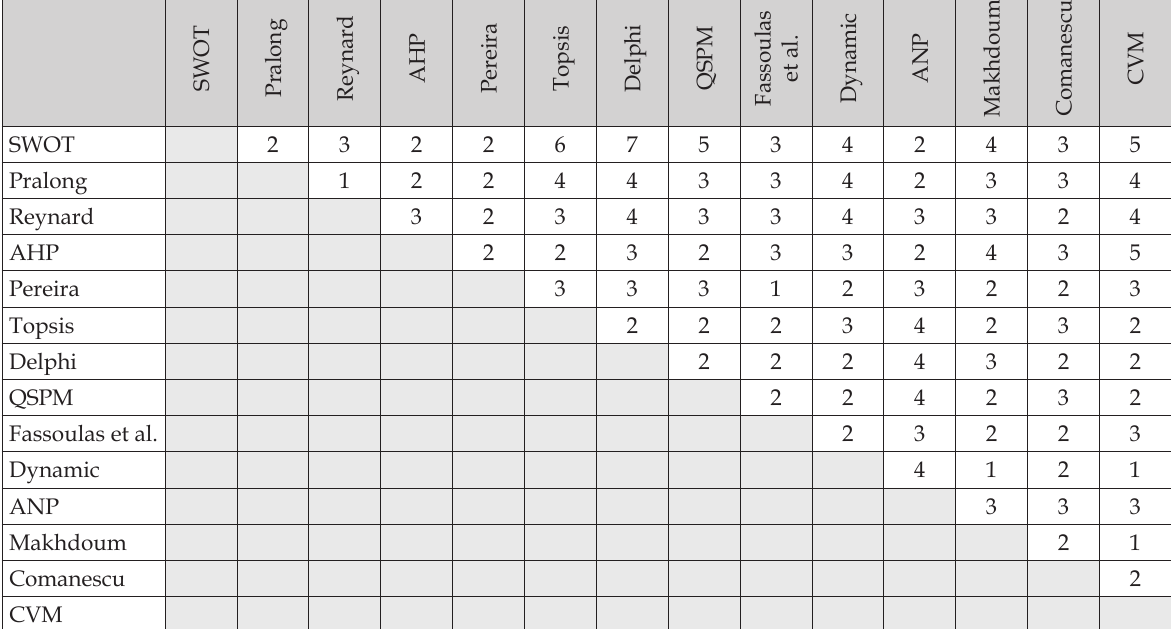
Table 8. The pairwise comparison matrix chart for ‘Ability of Assessment’ criterion in the expert choice soft- ware